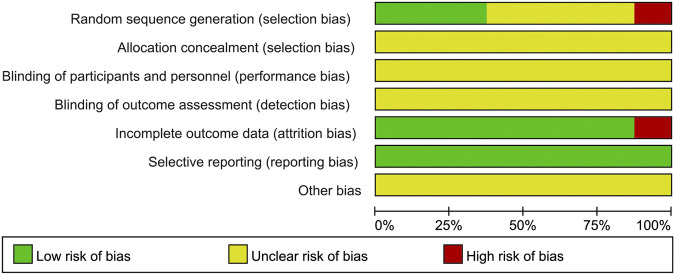
Risk of bias graph.